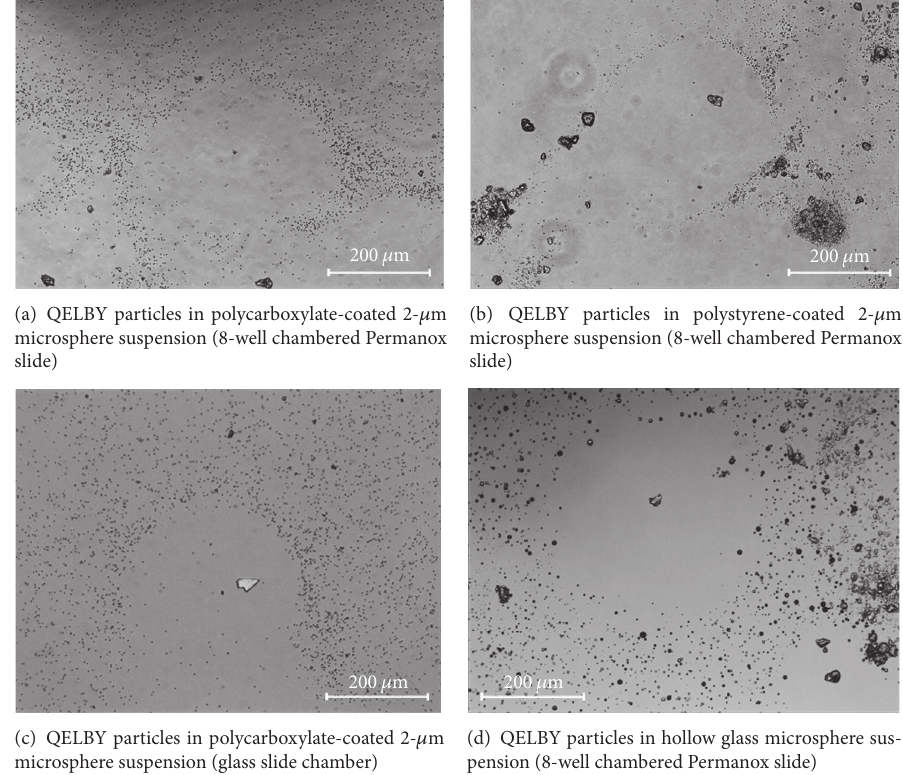
Figure 6: Clear zones, free of microspheres, were generated around single QELBY particles in various chambers and microsphere types (a–d).